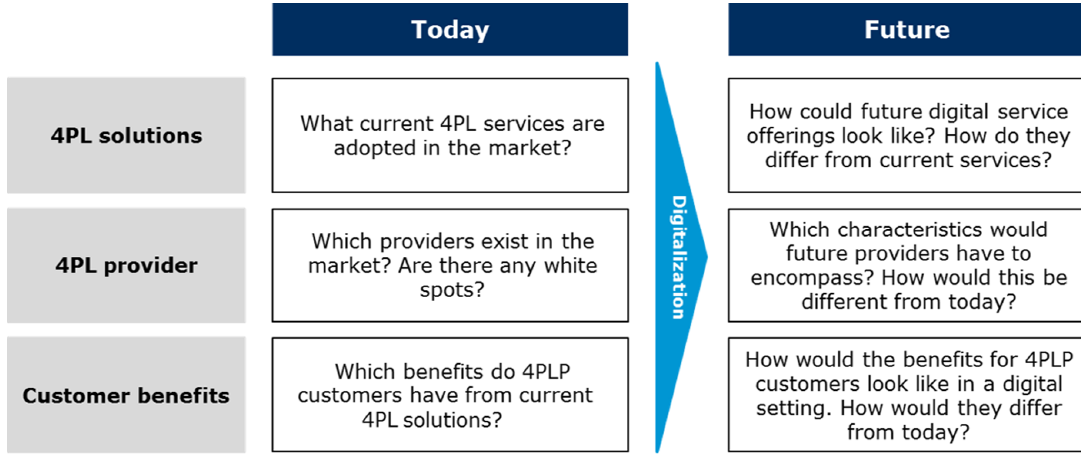
Figure 1. Overview of question frame for semi-structured interviews.